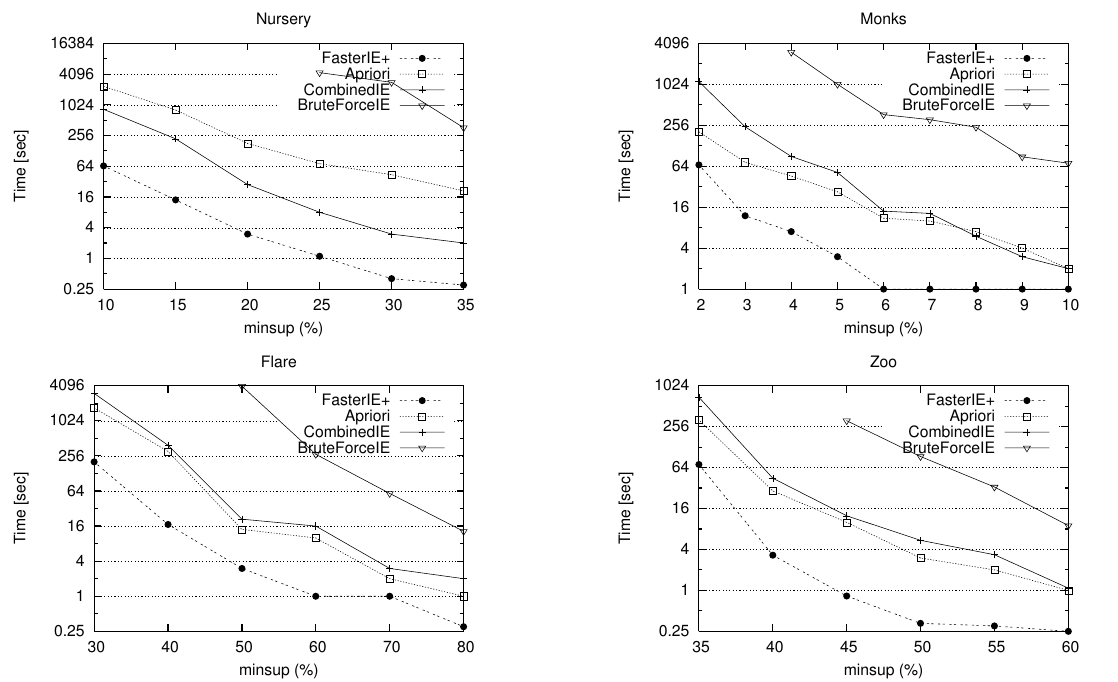
Figure 5. Comparison of the performances of F ASTER IE and those of the existing